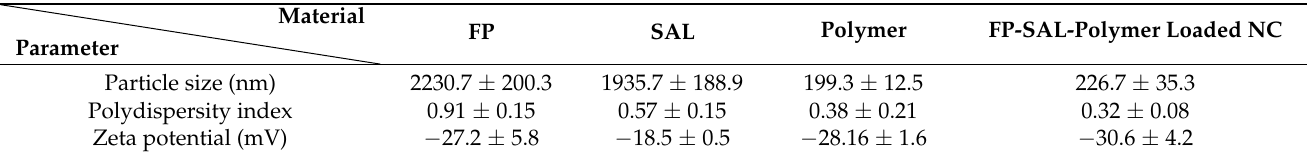
Table 1. Particle size analysis of fluticasone propionate (FP), salmeterol xinafoate (SAL), the polymer